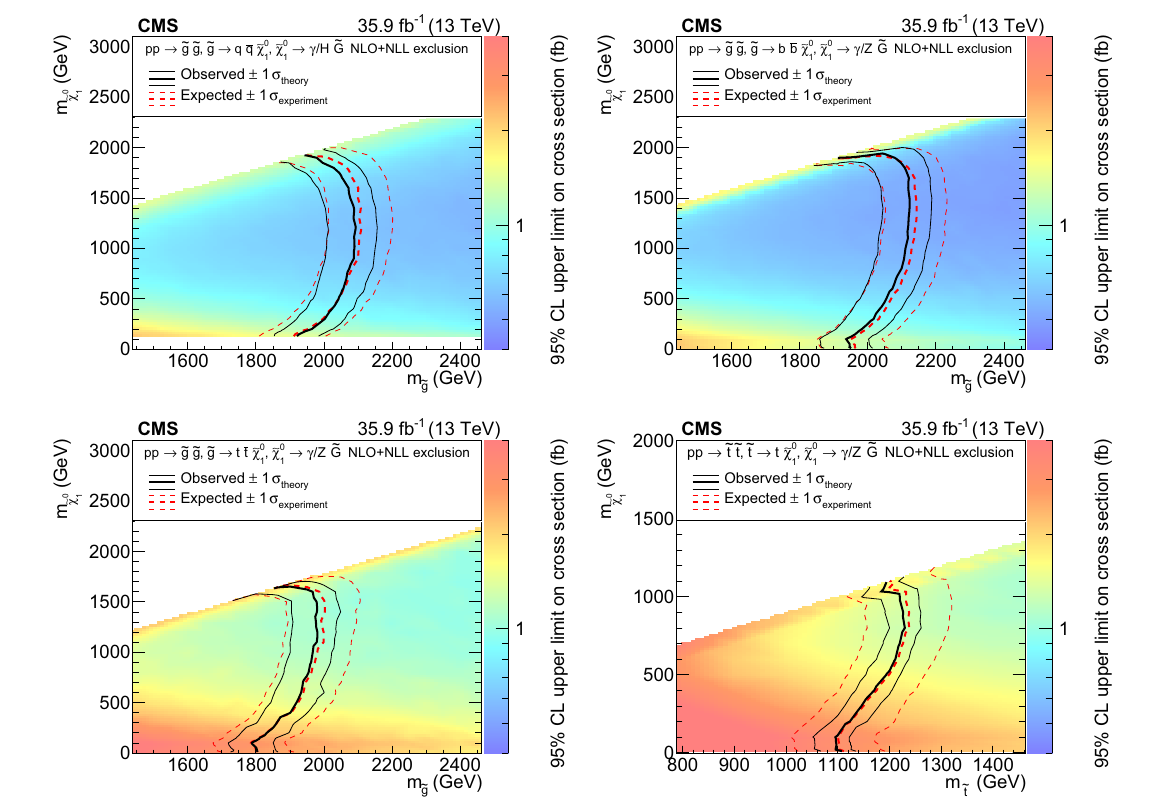
Fig. 5 Observed and expected 95% CL upper limits for gluino or top squark pair production cross sections for the T5qqqqHG (upper left), T5bbbbZG (upper right), T5ttttZG (bottom left), and T6ttZG (bottom right) models. Black lines denote the observed exclusion limit and the